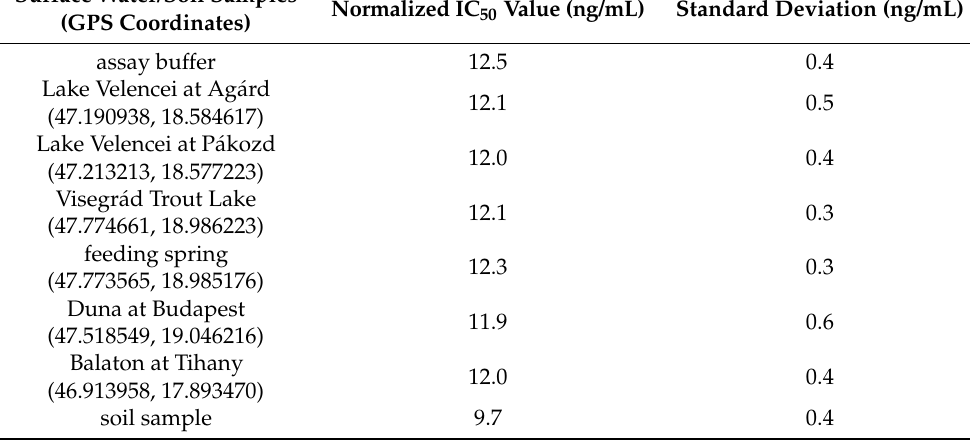
Table 5. Matrix effect in surface water and in soil extract determined by a comparison of IC 50 values obtained in the matrices and the calibration curve in assay